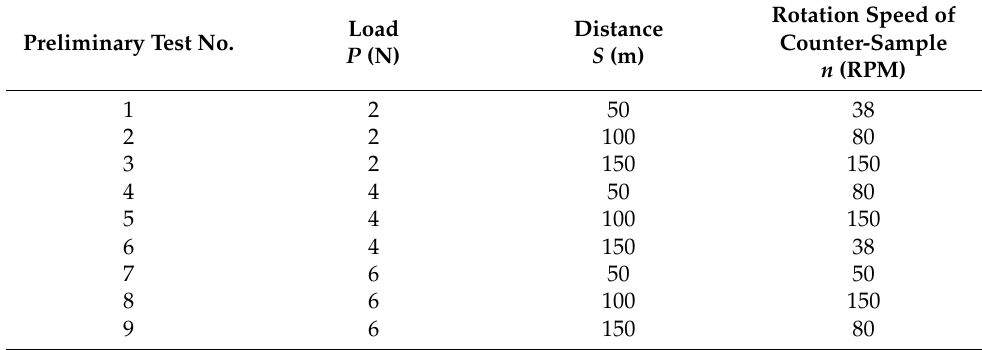
Table 2. Orthogonal table of preliminary tests.